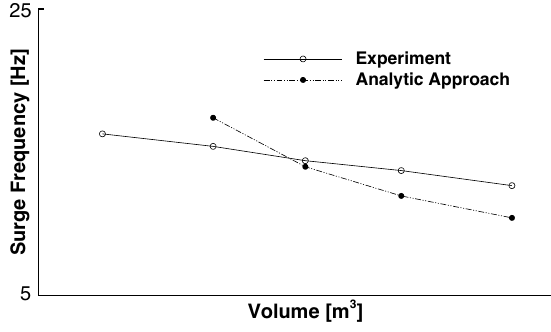
Figure 9. Surge frequency dependent on compressor exit